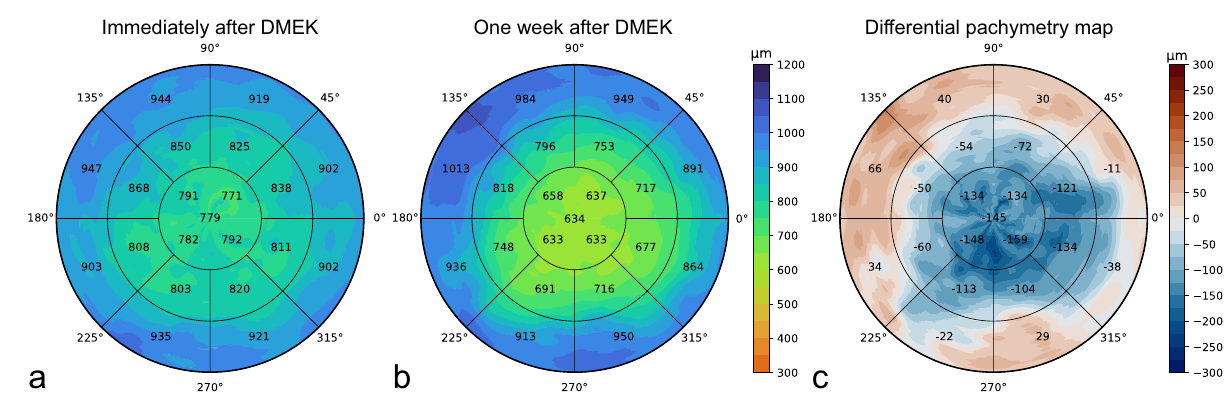
Figure 4. Example of pachymetry maps from one participant in the test set. ( a ) Pachymetry map of AS-OCT scan acquired immediately after DMEK; ( b ) Pachymetry map of AS-OCT scan acquired 1 week after DMEK; ( c ) Differential pachymetry map of difference in corneal thickness between ( b ) and ( a